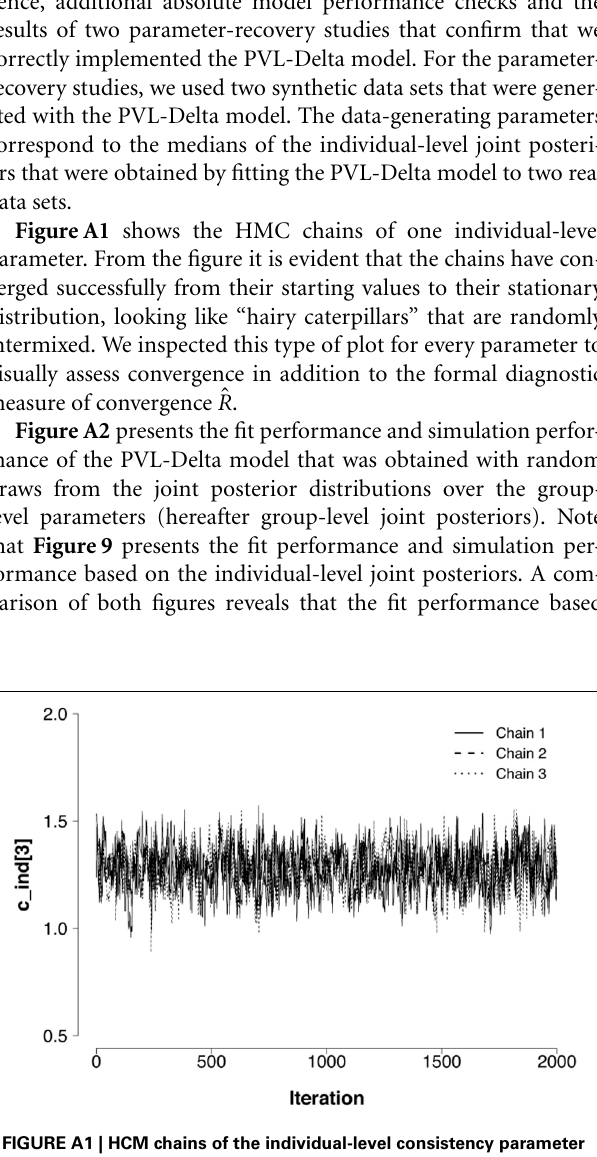
FIGURE A1 | HCM chains of the individual-level consistency parameter c of the third participant in the consistency condition. In addition to the formal diagnostic measure of convergence ˆ R , we inspected this type of plot for every parameter to visually assess